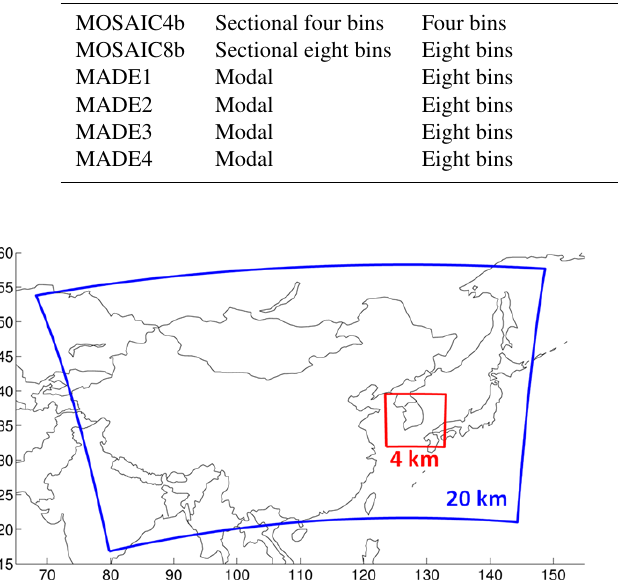
Figure 1. Modeling domains for the forecast simulations. Only the outer domain is used for the retrospective